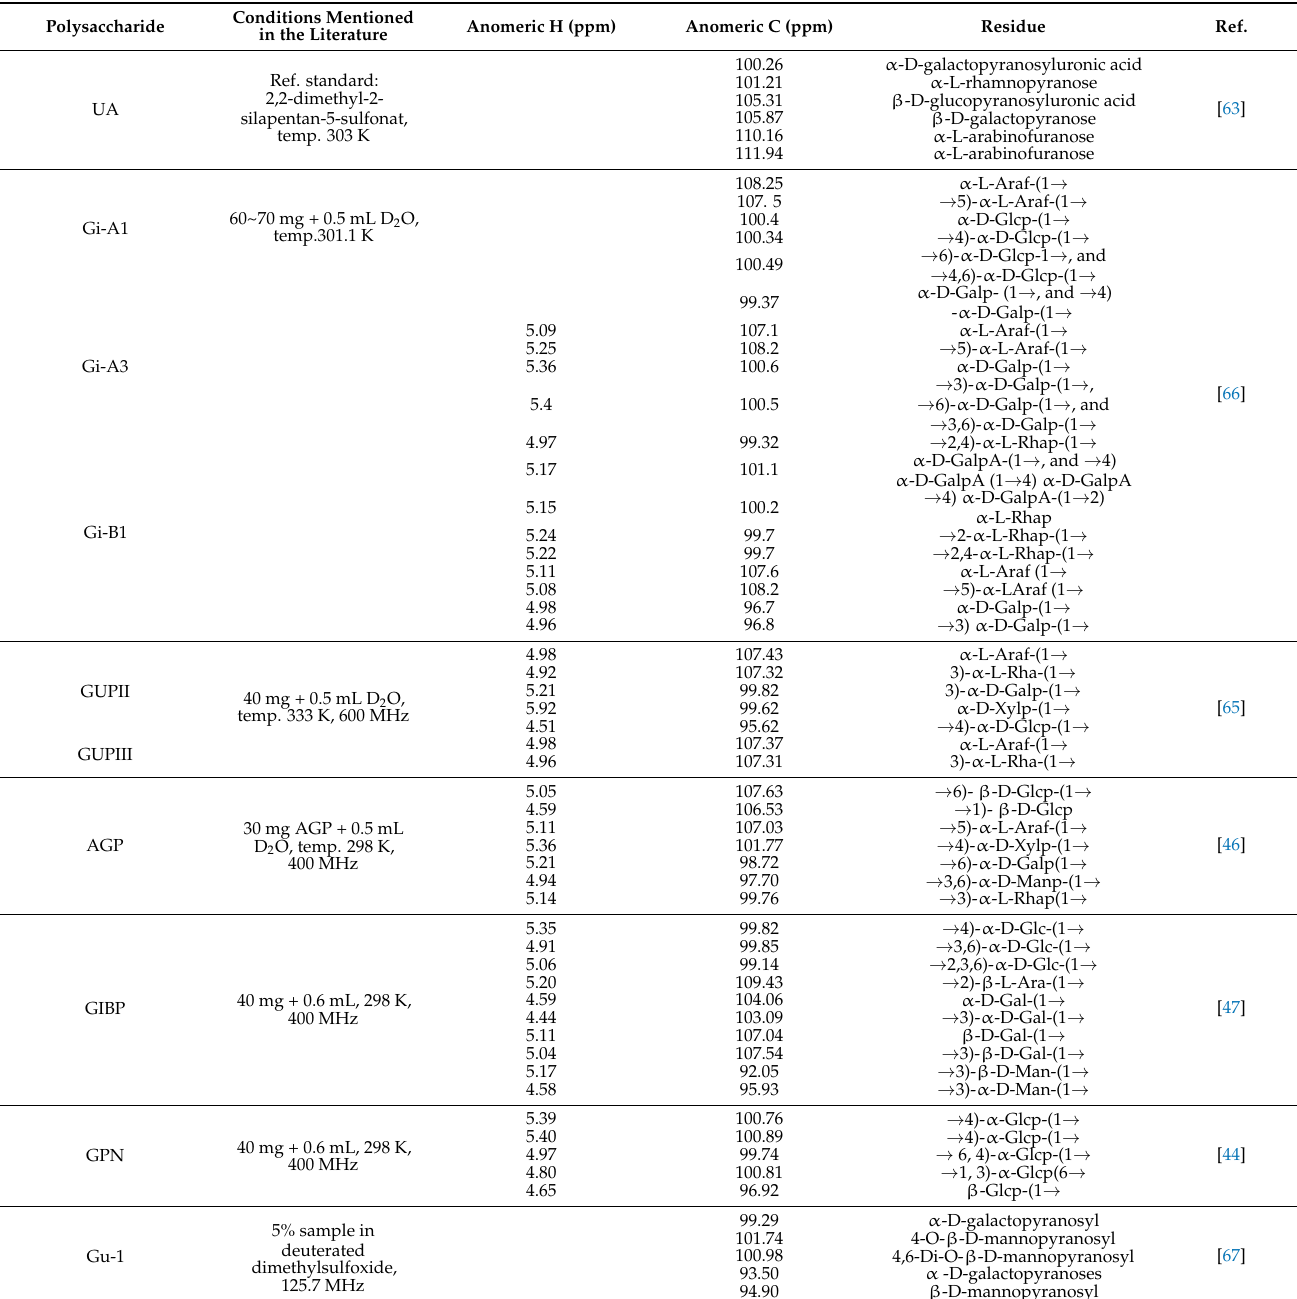
Table 2. 1 H and 13 C NMR chemical shift assignments of